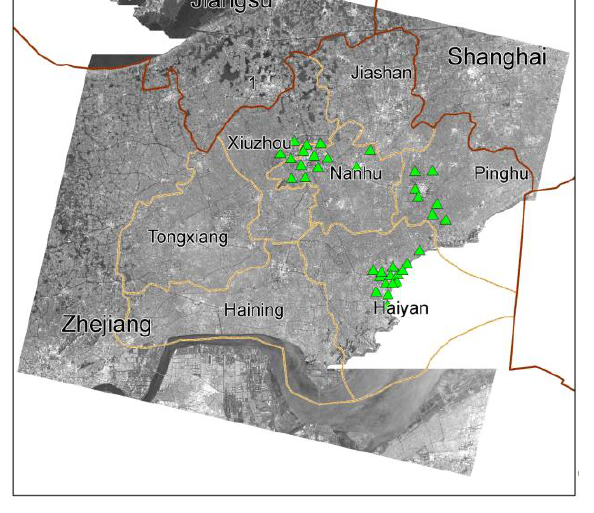
Figure 4. Distribution of levelling points